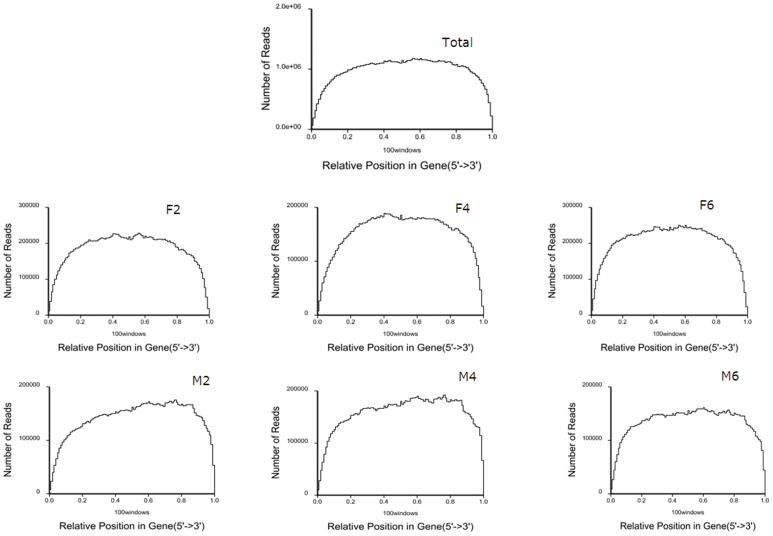
Random distribution of reads across genes.Note: Figure 1A–1G represent the reads across genes from the total RNA-seq dataset (All), reads from the skin fat sample at 2-, 4- and 6-weeks of age (F2, F4 and F6); reads from the breast muscle sample at 2-, 4- and 6-weeks of age (M2, M4 and M6) respectively,